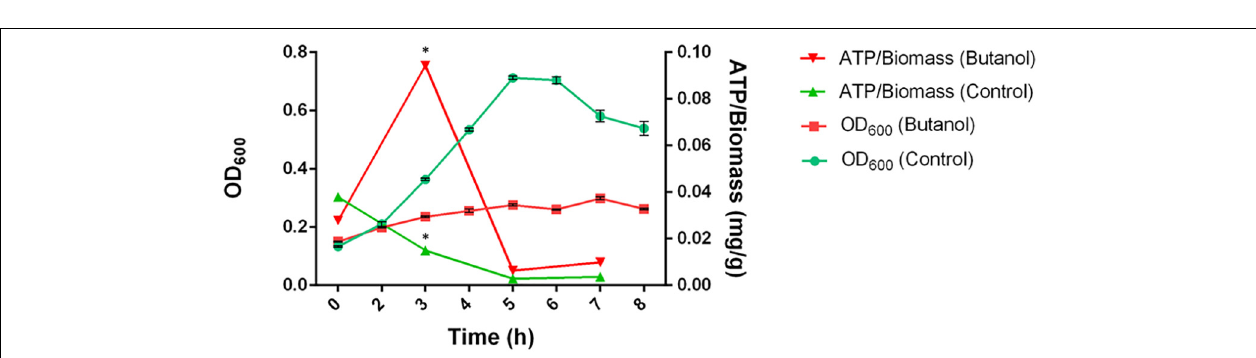
FIGURE 9 | Growth curve and intracellular ATP content of C. cellulovorans grown in control condition (green) or in butanol-supplemented medium (red). Bars represent standard deviations ( n = 3). Asterisks indicate values that significantly ( ∗ p -value < 0.01) differ between the two growth